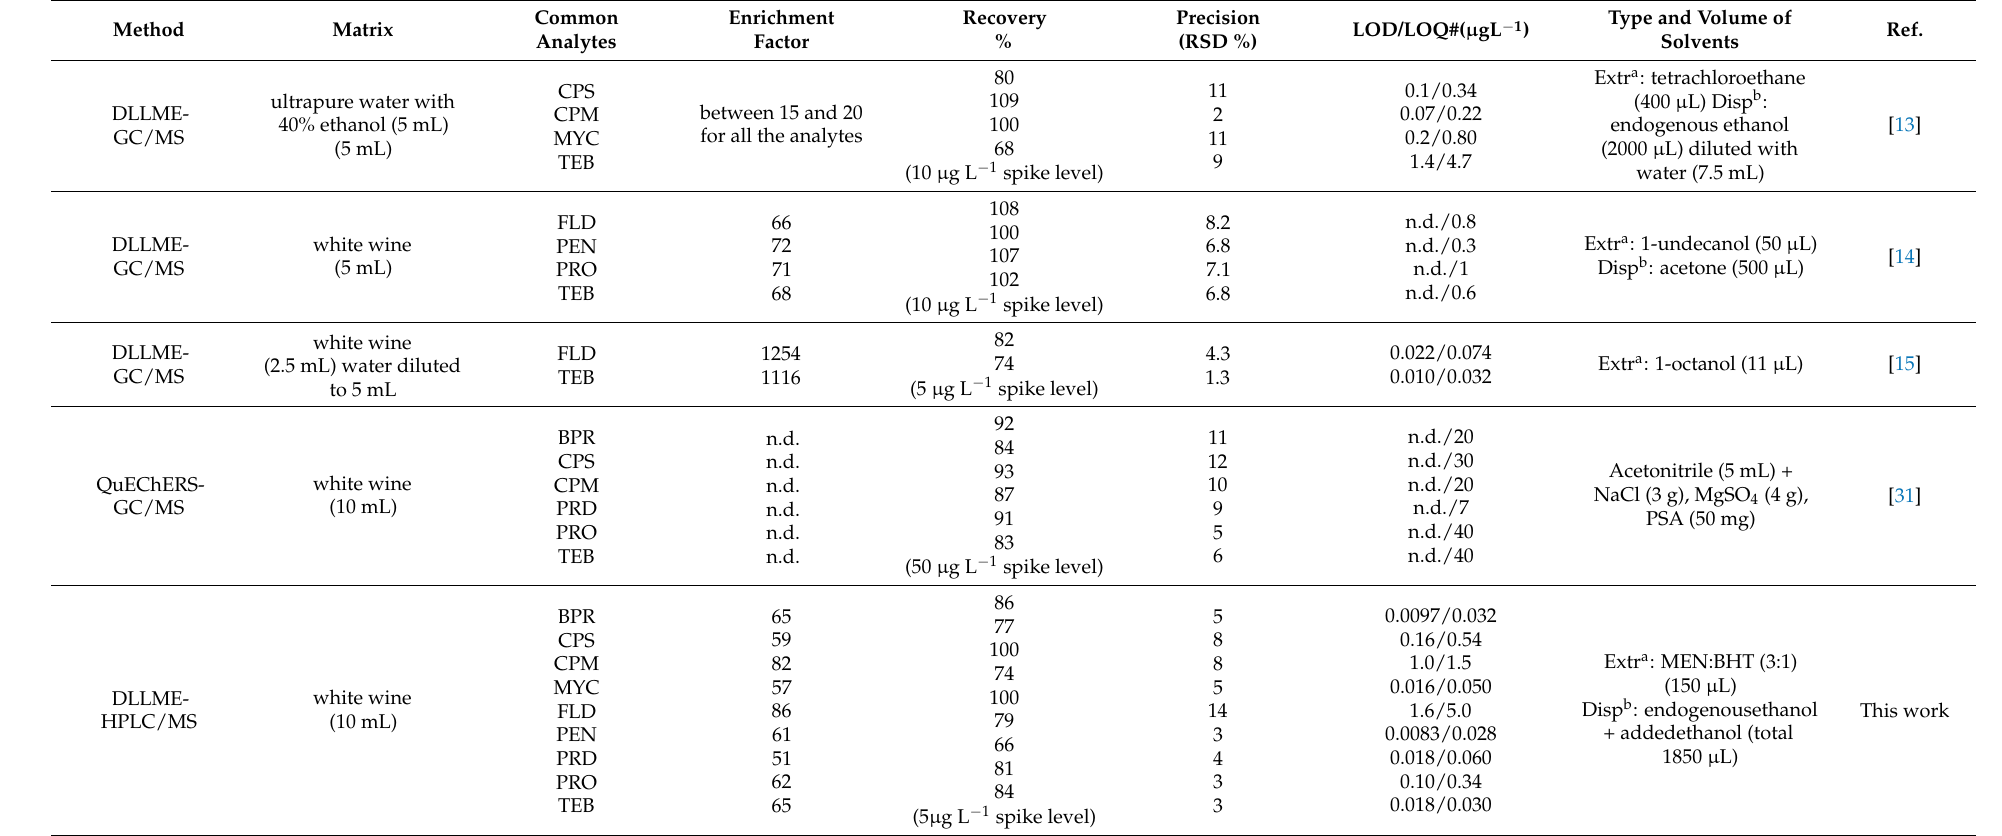
Table 3. Comparison of the main figures of merit of some methods involving the extraction of the same target compounds from